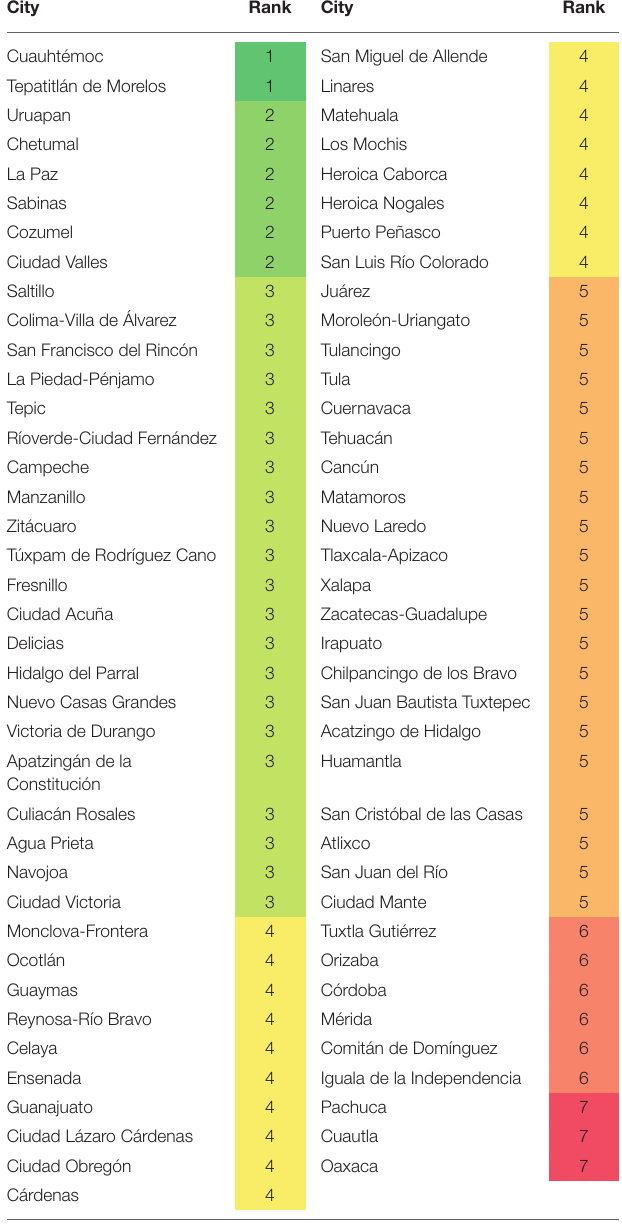
Colors from green to red denote higher to lower ranking in the composite index score.